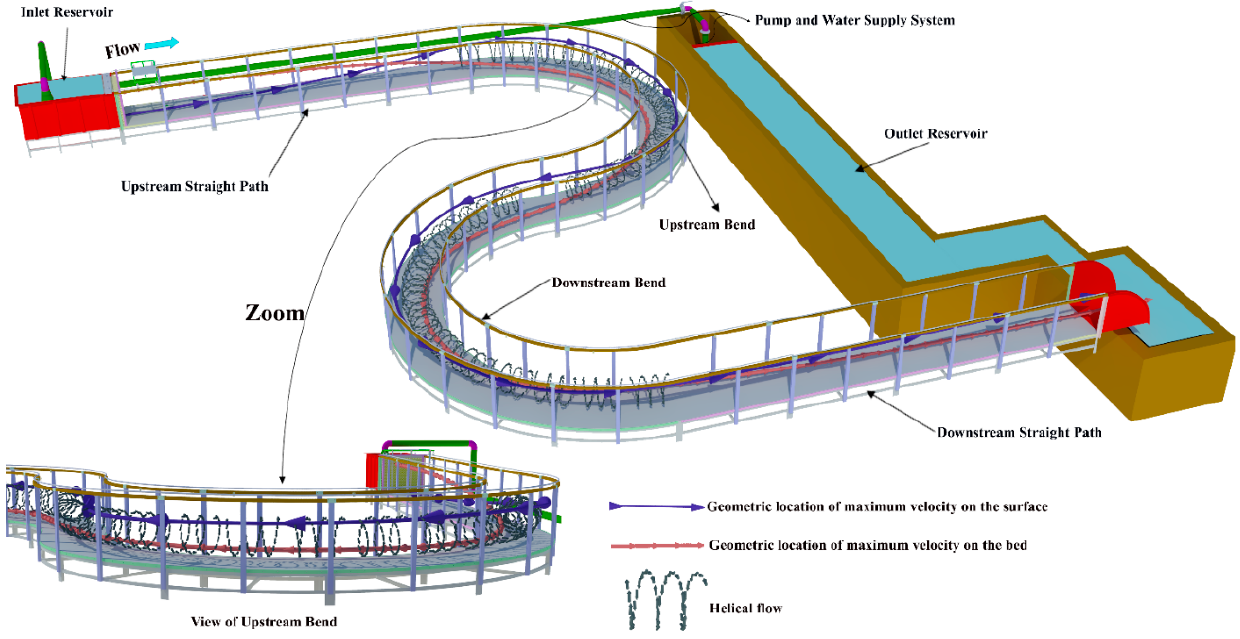
Figure 10. A schematic illustration of the 3D flow pattern at the layers near the bed and the water surface of the meandering channel.